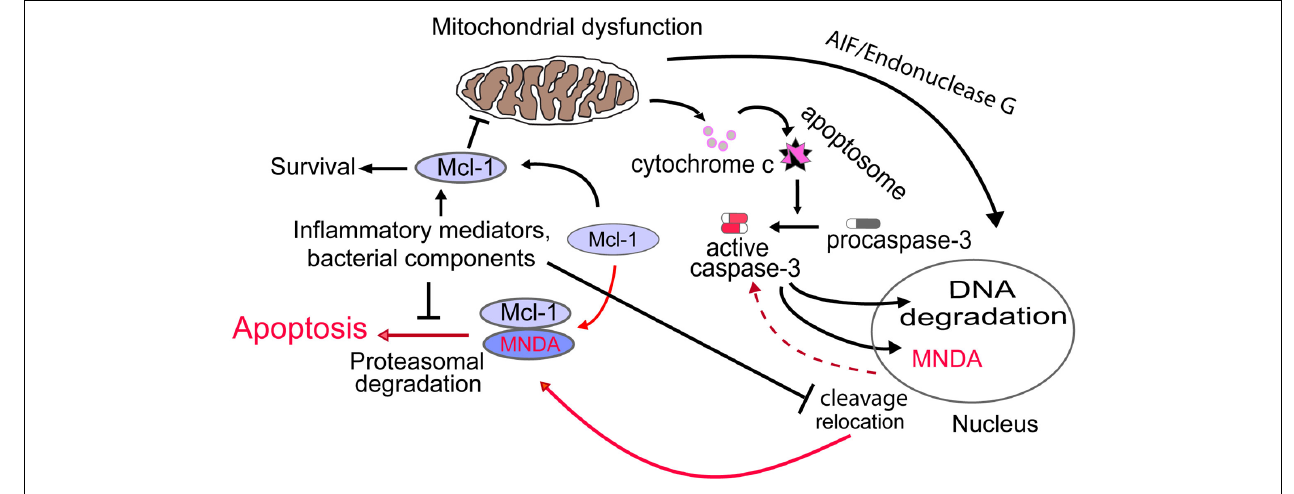
of MNDA relocation and cleavage would prolong neutrophil survival by retarding apoptosis.The mechanisms by which bacterial components and/or inflammatory modulators could negatively influence MNDA relocation and cleavage and hence, interfere with this nuclear-mitochondrial circuit remains to be defined. Broken line indicates yet undefined